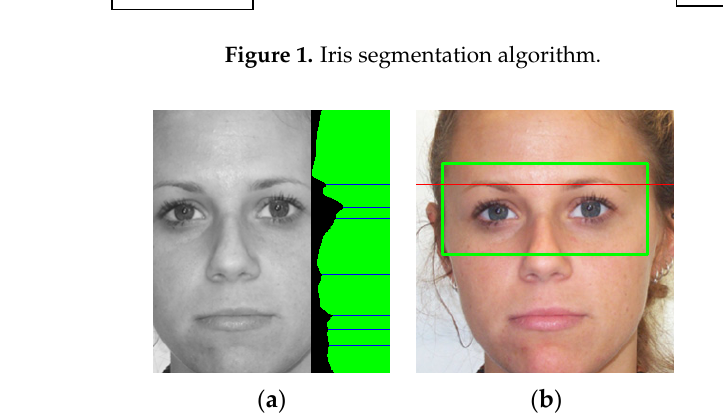
Figure 2. Eye region selection. ( a ) Cropped face image and vertical image projection (on the right). The local minima of the image projection are drawn with blue lines; and ( b ) the selected eye area (the green rectangle) and the estimated position of the eyebrow row (the red line).